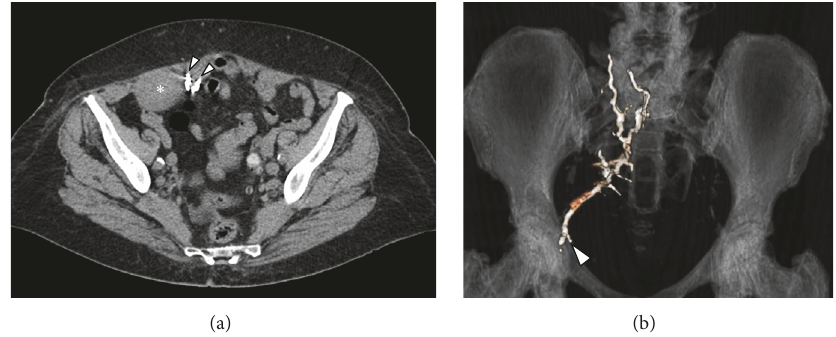
Figure 3: (a) MD-CT axial view at one month demonstrates the reduction of the haematoma into the right rectus sheath ( ∗ ) with two hyperdense artefact due to the Squidperi liquid embolic material. (b) MD-CT coronal Volume Rendering Technique image at three months with right epigastric artery reconstruction (arrowhead) filed by Squidperi 18 liquid embolic